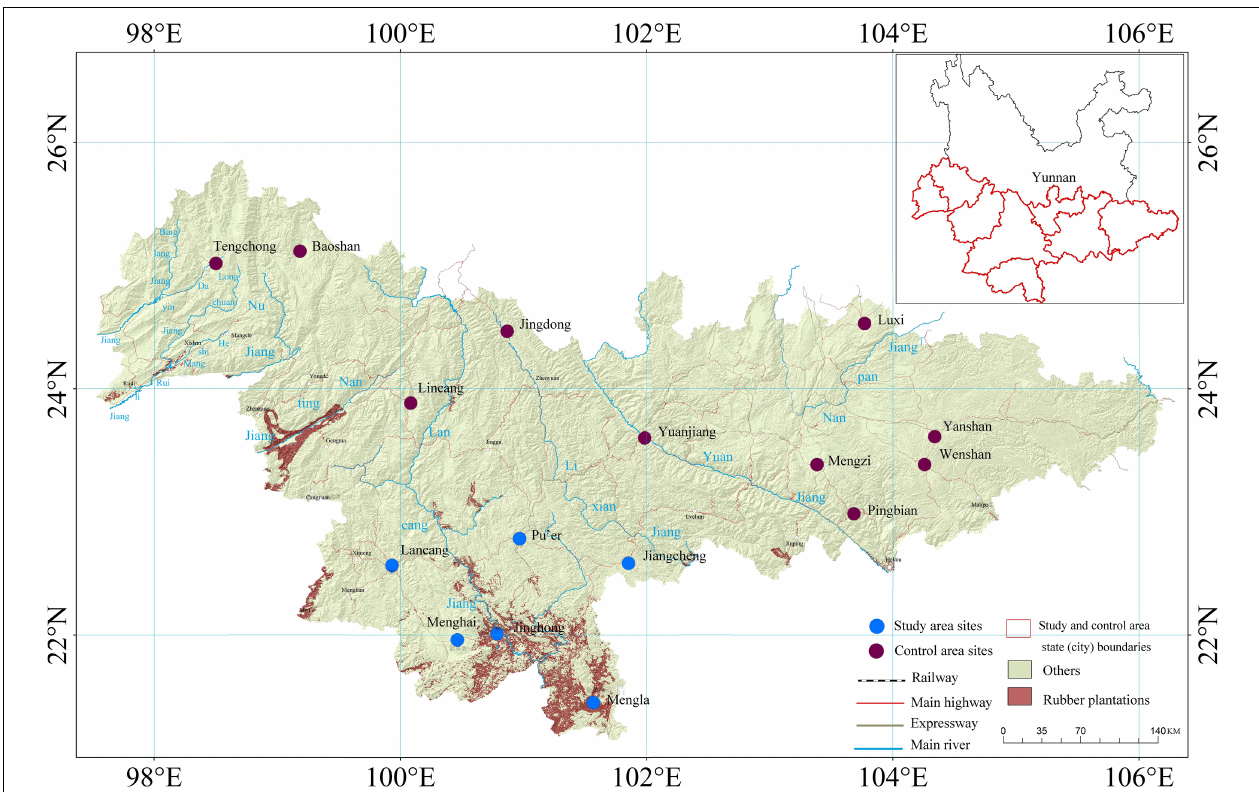
FIGURE 1 | Map of National Meteorological Stations in study area and control